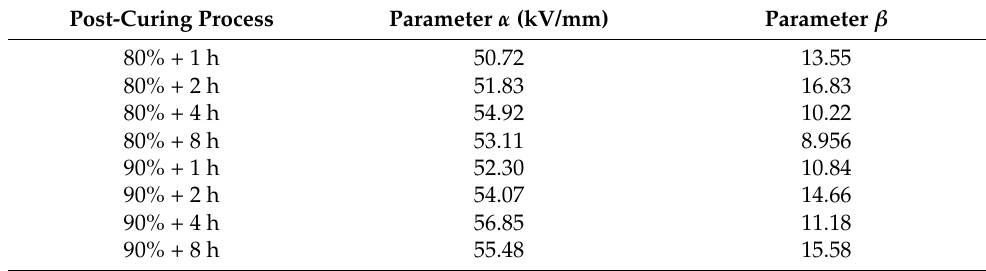
Table 4. Effects of post-curing process on the breakdown characteristics of DEBGA/MHHPA system under 100 ◦ C